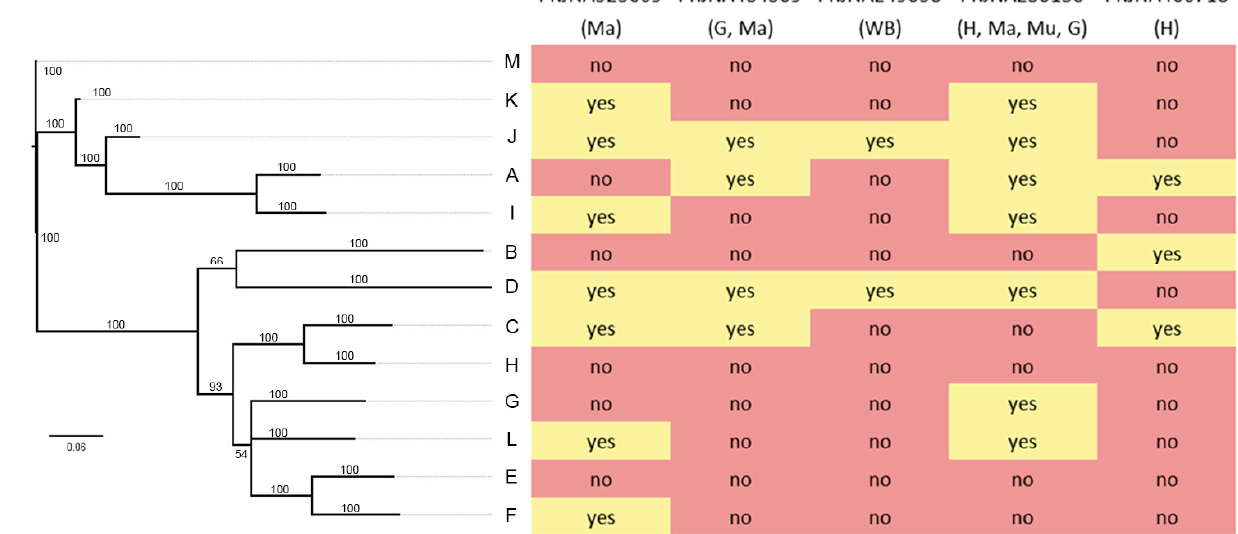
Figure 7. Expression analysis. A total of five transcriptomes of different tissues and mussel locations were analyzed to find evidence of expression of sequences belonging to each cluster. The isoforms expressed in each transcriptome are highlighted in yellow. Red color indicates no evidence of expression.